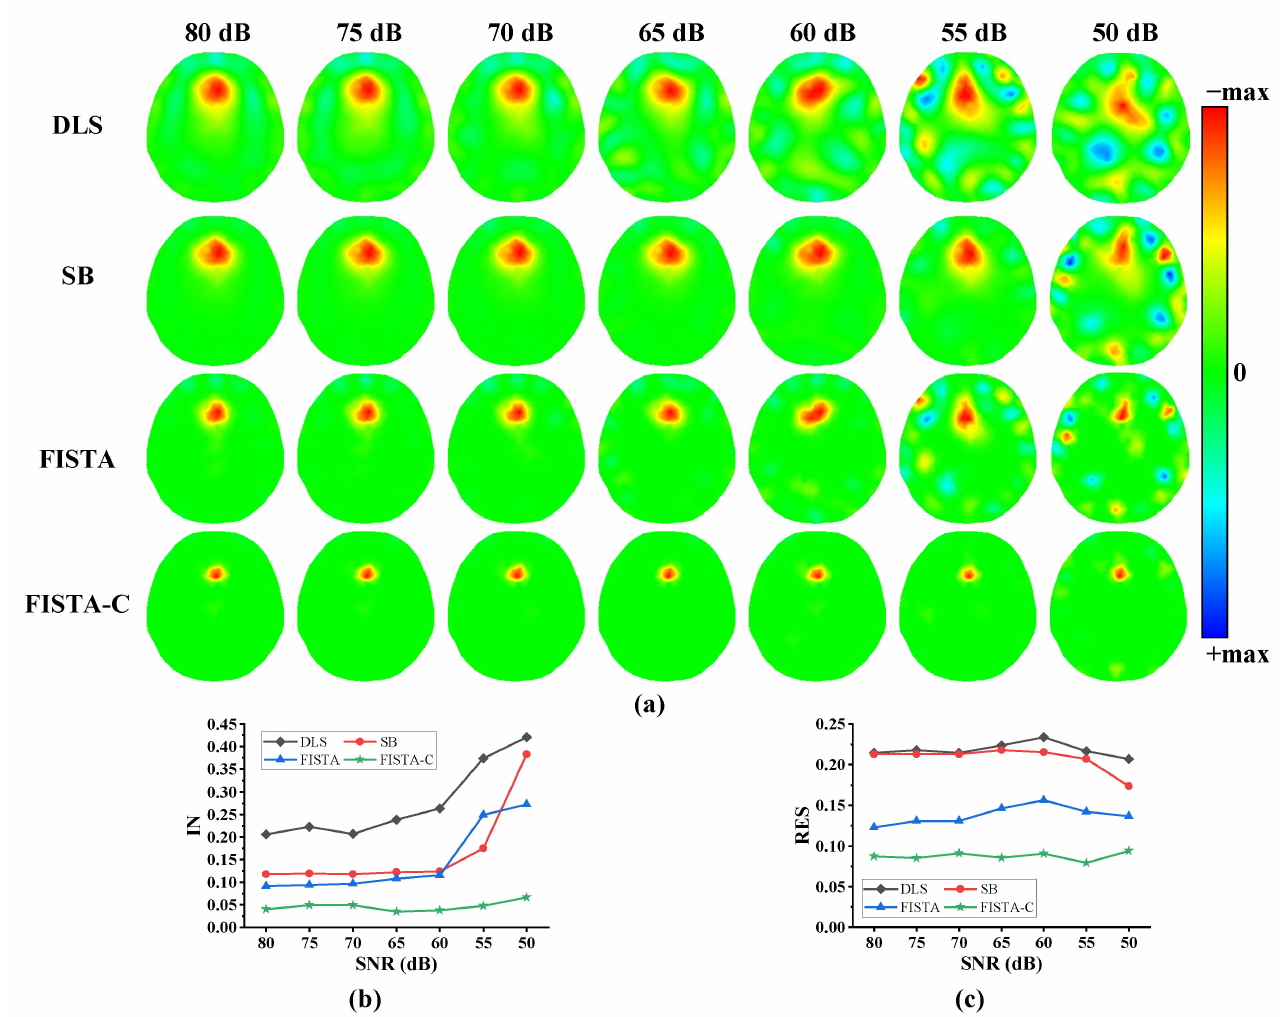
Figure 5. Analyses of reconstruction performances of four algorithms under various noise lev- els. ( a ) The first to fourth rows are imaging results of DLS, SB, FISTA, and FISTA-C, respectively, with an SNR of 80–50 dB. ( b ) Image noise (IN) analyses of imaging results of the four algorithms. ( c ) Resolutions of imaging results for the four algorithms. (std: standard